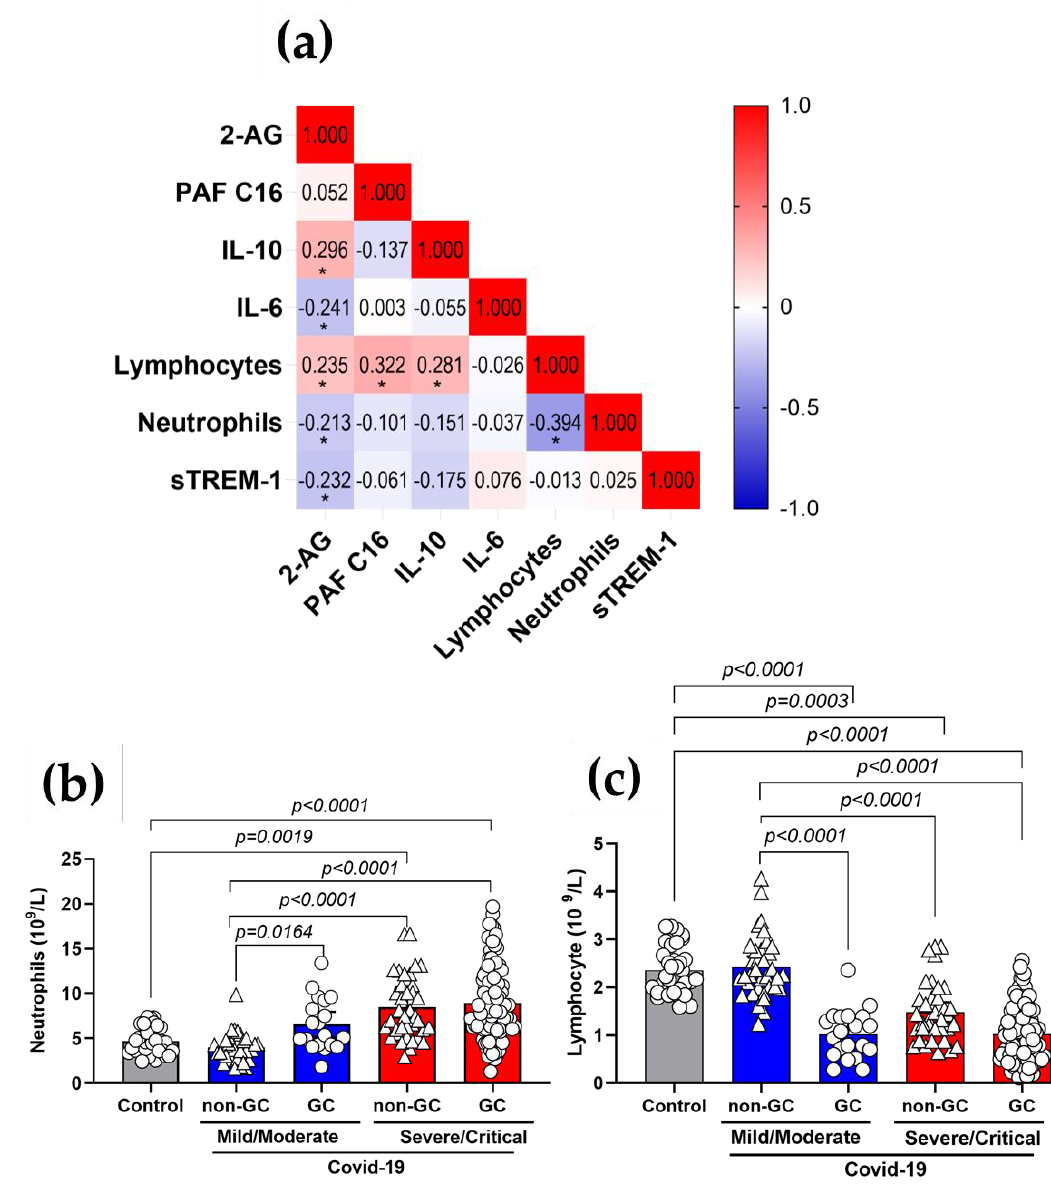
Figure 4. Correlations of 2-AG and PAF C16 with inflammatory markers of COVID-19 patients. ( a ) Correlation matrix demonstrating interactions between levels of 2-AG, PAF (16:0) and the in- flammatory parameters, IL-10, IL-6, sTREM-1, lymphocytes and neutrophil counts. Color scale sidebar indicates correlation coefficients ( r ), color-coded: red, positive correlation; blue, negative correlation; the intensity of the color represents the intensity of the correlation. Values adjust between − 1.0 and 1.0. The significance levels indicated with gray asterisks are based on the p < 0.05 of the Spearman’s correlation coefficient ( r ) *. ( b ) Absolute values of neutrophils and ( c ) lymphocytes in patients GC-treated or not with COVID-19 mild/moderate (non-GC, n = 35 vs. GC, n = 20) and severe/critical (non-GC, n = 42 vs. GC, n = 103). Statistical analyses were performed using the Kruskal–Wallis multiple comparison test (non-parametric), followed by Dunn’s post-test. Data are expressed as median in boxplot graphs with minimum and maximum values with a confidence interval of +/ − 95%. Significance levels shown are based on statistically significant p < 0.05 between